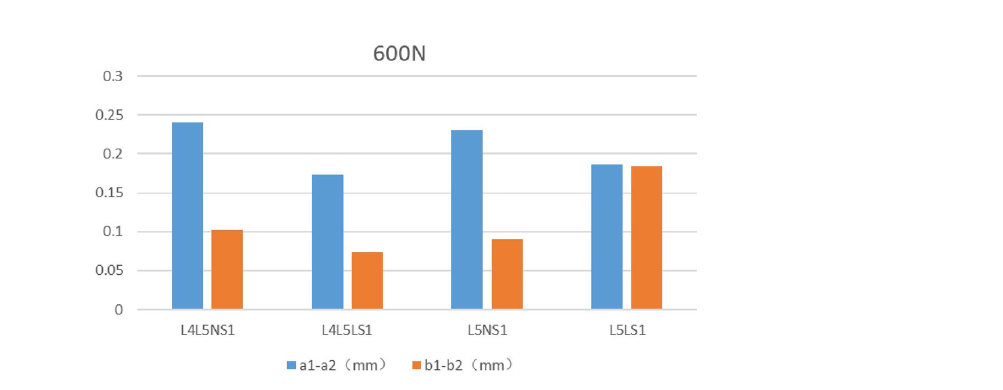
Figure 8. Fracture separation value under 600N vertical